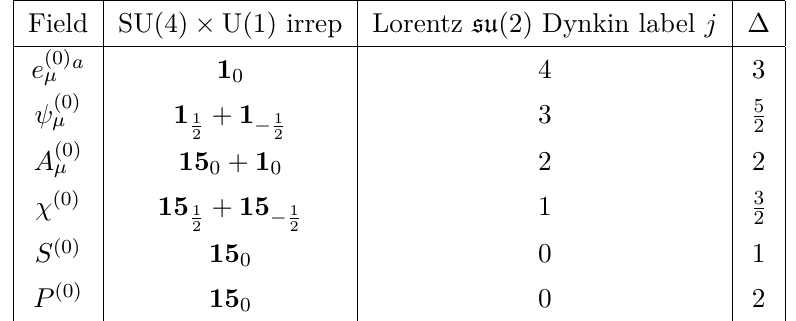
Table 4 . The KK spectrum for the level n = 0 of 11d supergravity on AdS 4 × S 7 / Z 4 with the antiperiodic spin